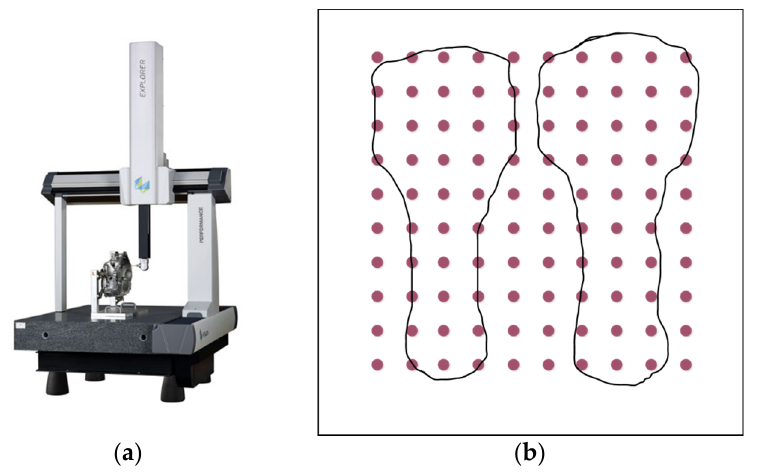
Figure 7. ( a ) Three-coordinate measuring instrument (Hexagon); ( b ) schematic diagram of 10 × 10 point cloud matrix.